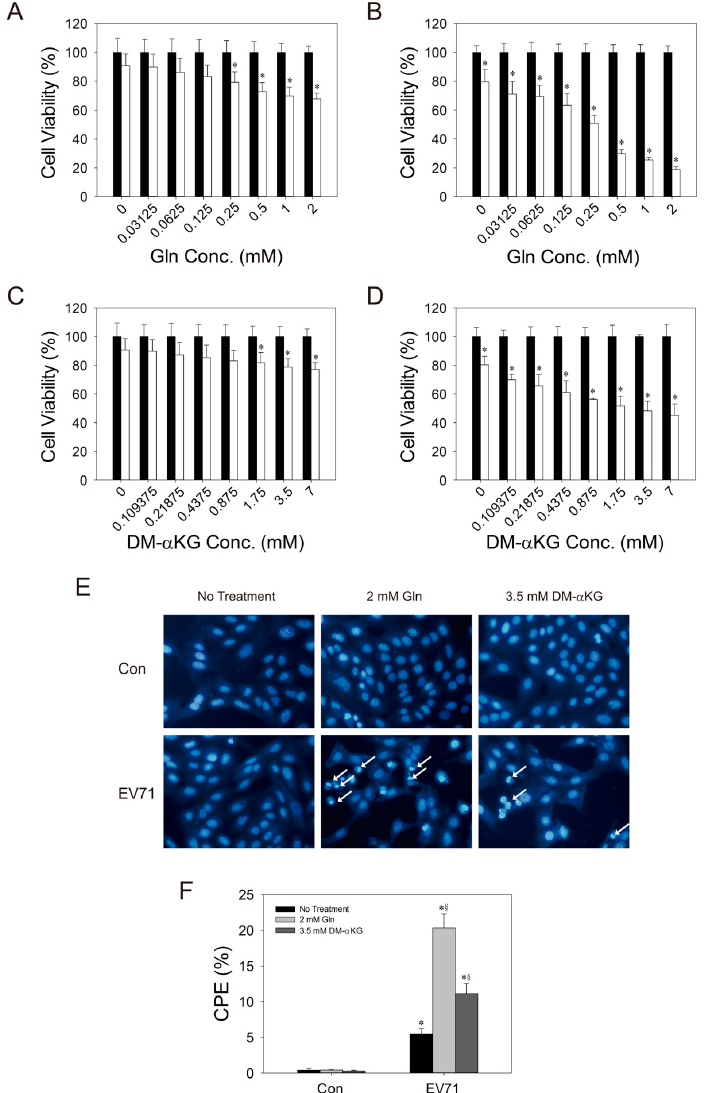
Figure 4. Glutamine deprivation rescues cells from viability loss and cytopathic effect. Vero cells were cultured in medium containing the indicated concentrations of glutamine (Gln) ( A , B ), or in glutamine-free medium supplemented with the indicated concentrations of DM- α KG ( C , D ). They were mock- (solid bar) or infected (empty bar) with EV71 at MOI of 1.25 for 24 ( A , C ) and 48 h ( B , D ), and the viability was assayed by neutral red assay. The data are expressed as percentage relative to those of mock-infected cells and presented as mean ± SD of six separate experiments. * p < 0.05, significant di ff erence from mock-infected cells at a specified concentration. ( E ) Cells were cultured in glutamine-free medium (no treatment), medium containing 2 mM Gln, or glutamine-free medium containing 3.5 mM DM- α KG, and were mock- (Con) or infected ( EV71 ) with EV71 for 24 h. They were stained with Hoechst 33342 and examined under a fluorescence microscope. The white arrows indicate cells with CPE. The results shown are representative of six experiments (original magnification: × 200). The cells with CPE are those characterized by chromatin condensation and formation of crescent-shaped nuclei. ( F ) The percentage of such cells, taken as a measure of CPE, was determined by IN Cell Analyzer 1000. Data are means ± SD of three experiments. * p < 0.01, significant di ff erence from mock-infected cells for the indicated treatment; § p < 0.05, significant di ff erence from the no-treatment